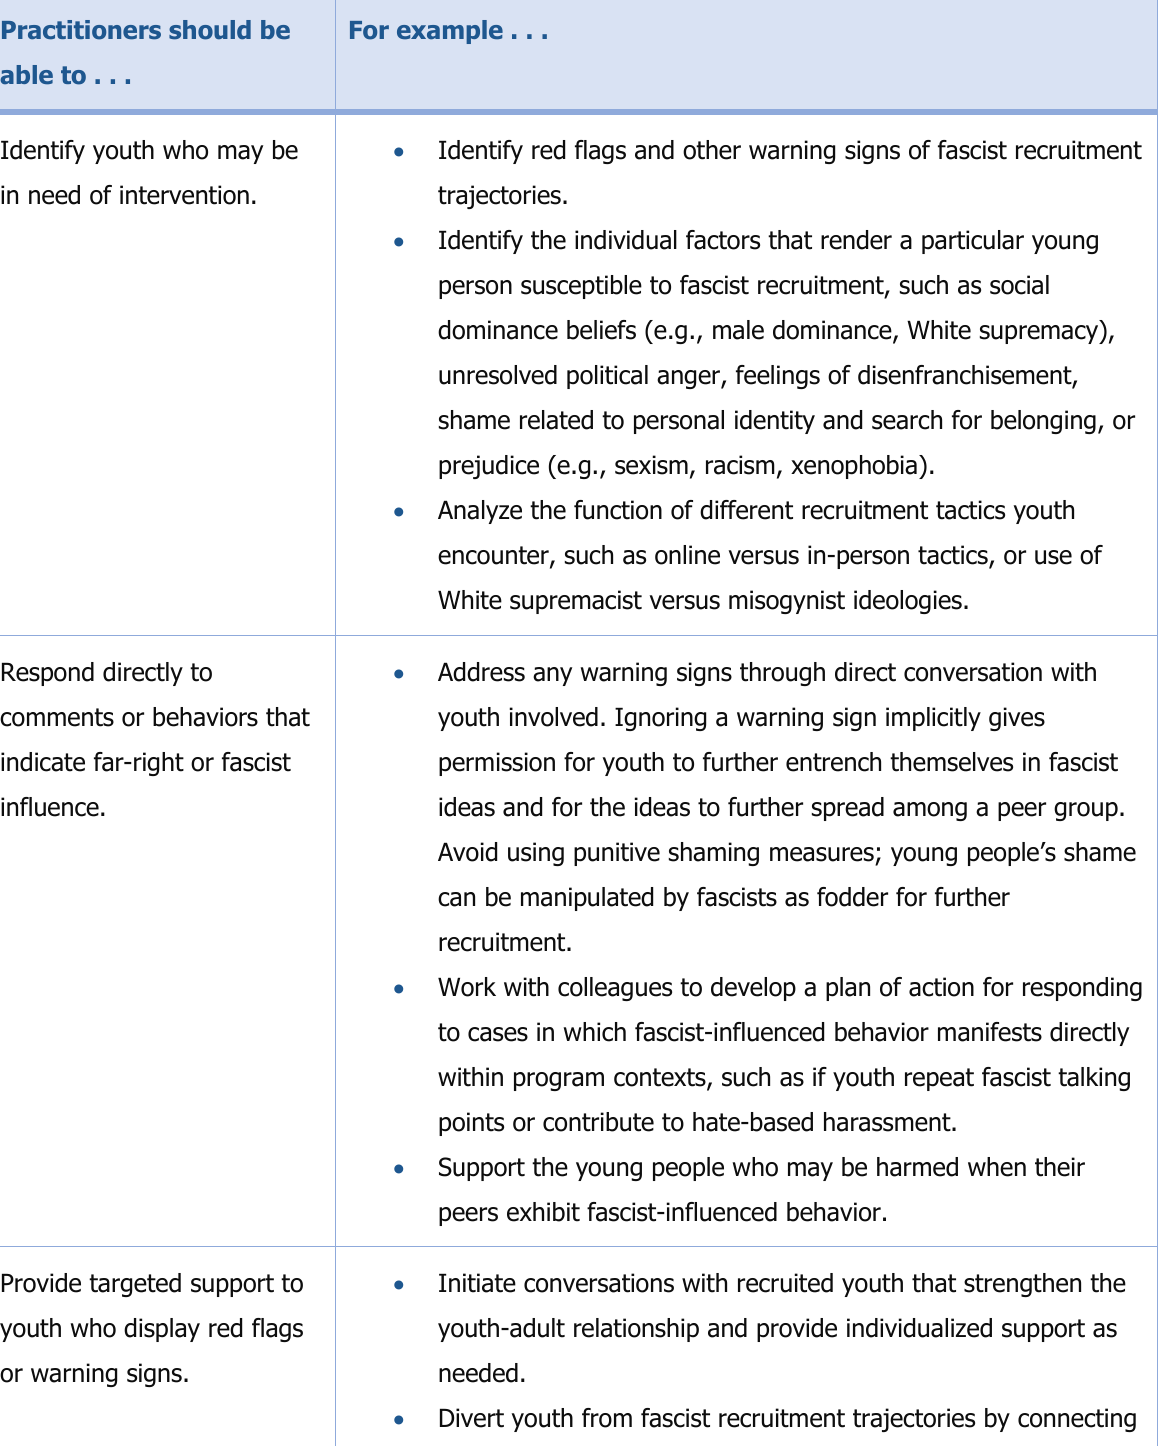
Table 2. Intervention Strategies and Examples Practitioners should